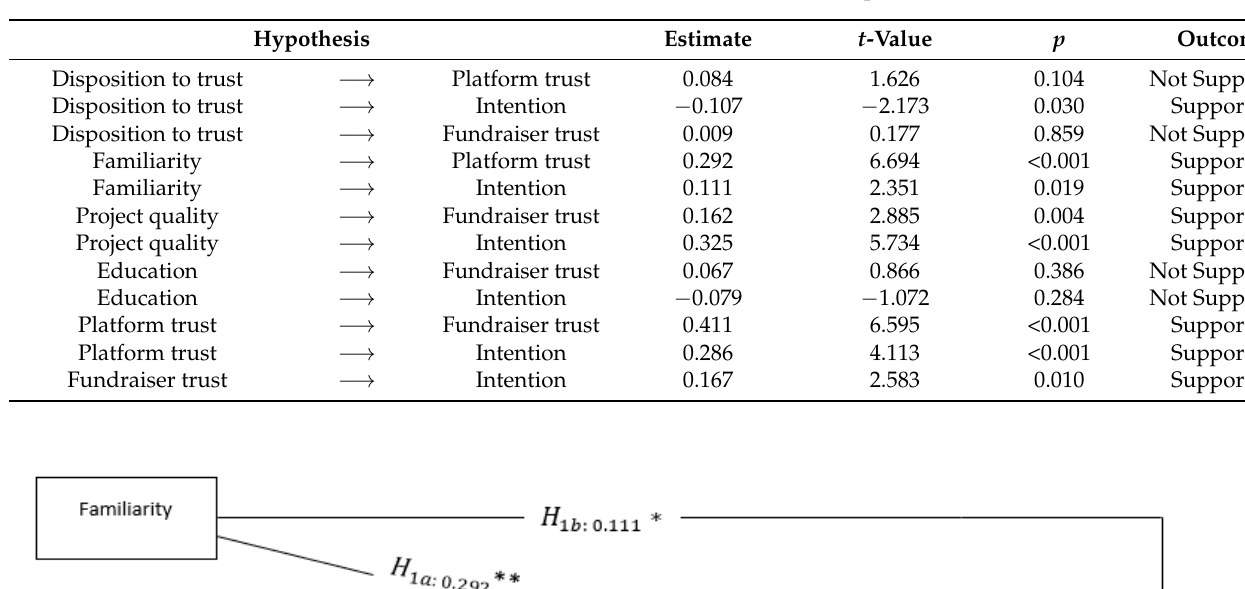
Table 5. Results: evaluation of the SEM model paths.